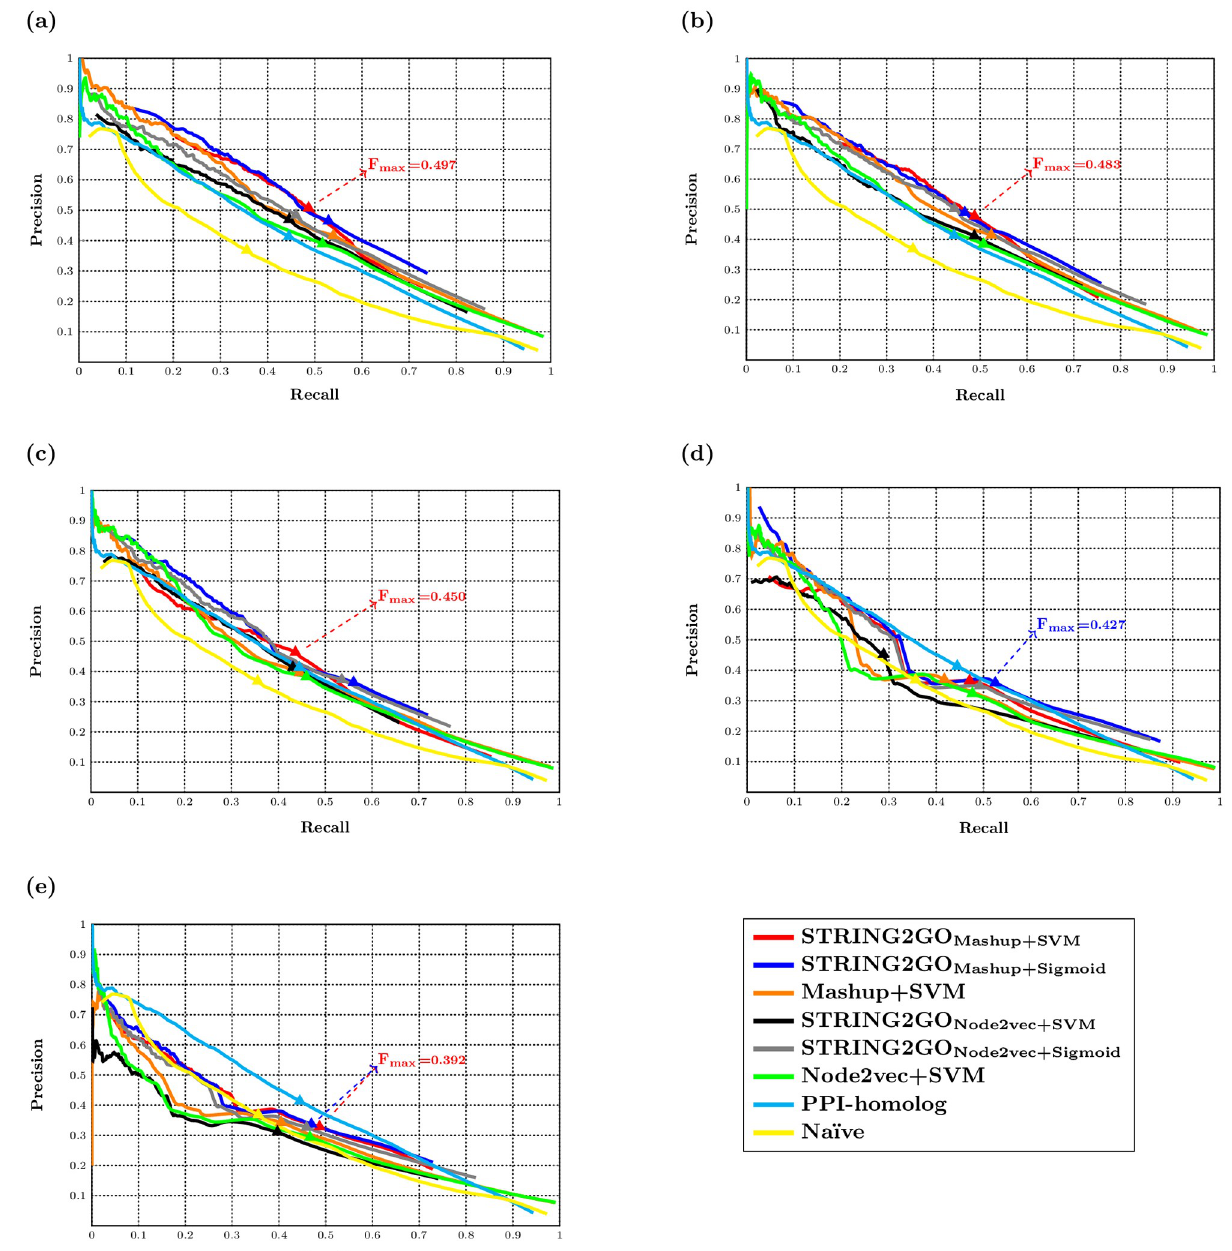
Fig 4. Precision-recall curves of different methods and the F max scores obtained by the best-performing methods based on (a) Combinedscore, (b) Textmining, (c) Experimental, (d) Database and (e) Coexpression networks.